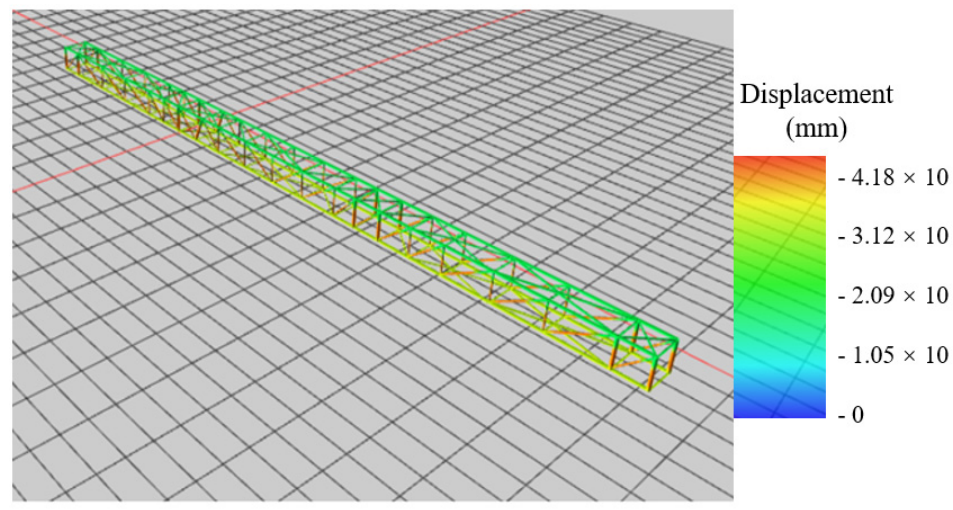
Figure 22. Deflection of selected members of the long − span converter station steel structure.